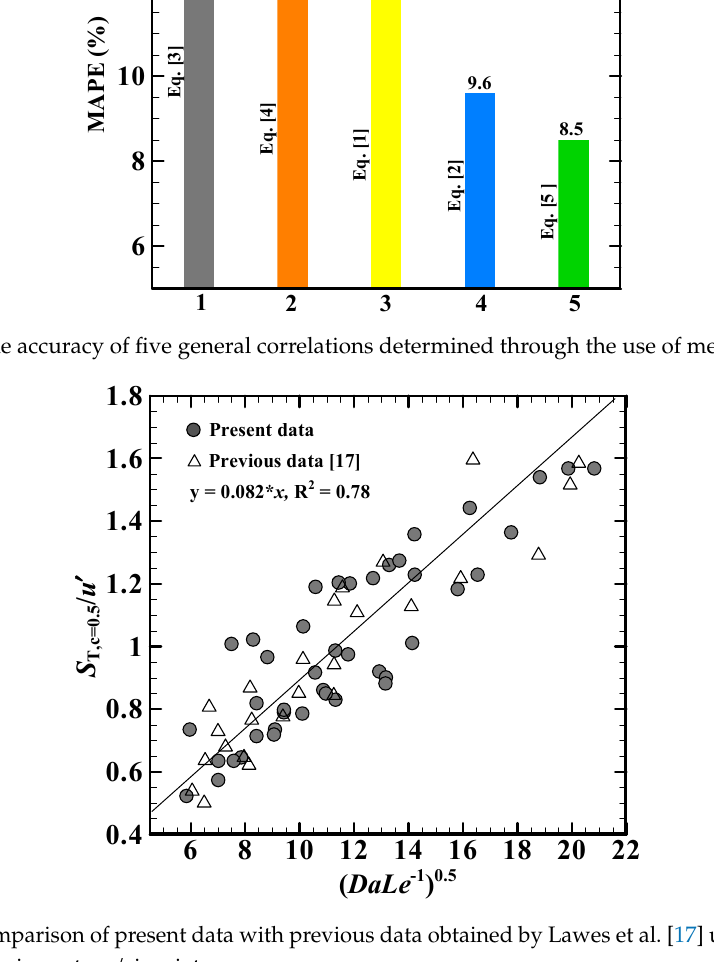
(1) Turbulent burning velocities increase with increasing pressure and temperature at any given r.m.s turbulent fluctuating velocities. However, the increase of turbulent burning velocities is quite small at modest u ′ = 1.4 m/s, which is much less sensitive with the increase of pressure and temperature as compared to that at higher values of u ′ . (2) The bending effect of S T, 𝑐̅ =0.5 / S L vs . u ′ / S L curves is observed at higher u ′ / S L . (3) Le < 1 flames (the rich iso-octane/air mixture) propagate faster than Le > 1 flames (lean and/or stoichiometric iso-octane/air mixtures) at any given conditions. (4) All present iso-octane S T,c = 0.5 data with Le < 1 and Le > 1 can be collapsed onto single curves regardless of different T , p , u ′ , φ , and Le used, which can be represented by five general correlations (Equations (1)–(5)), suggesting that turbulent premixed spherical flames have a self-similar propagation nature. These five general correlations have reasonable good accuracy due to their low values of MAPE (MAPE < 13%). The fundamental understanding of flame initiation and propagation of lean iso-octane/air mixtures through the interactions of centrally-ignited outwardly-propagating premixed flame and intense turbulence at high pressure and high temperature is of importance for the future development of high-thermal-efficiency SI gasoline engines operated at fuel lean conditions. This is because premixed lean-burn technology can increase the mixture specific heat ratio and decrease the